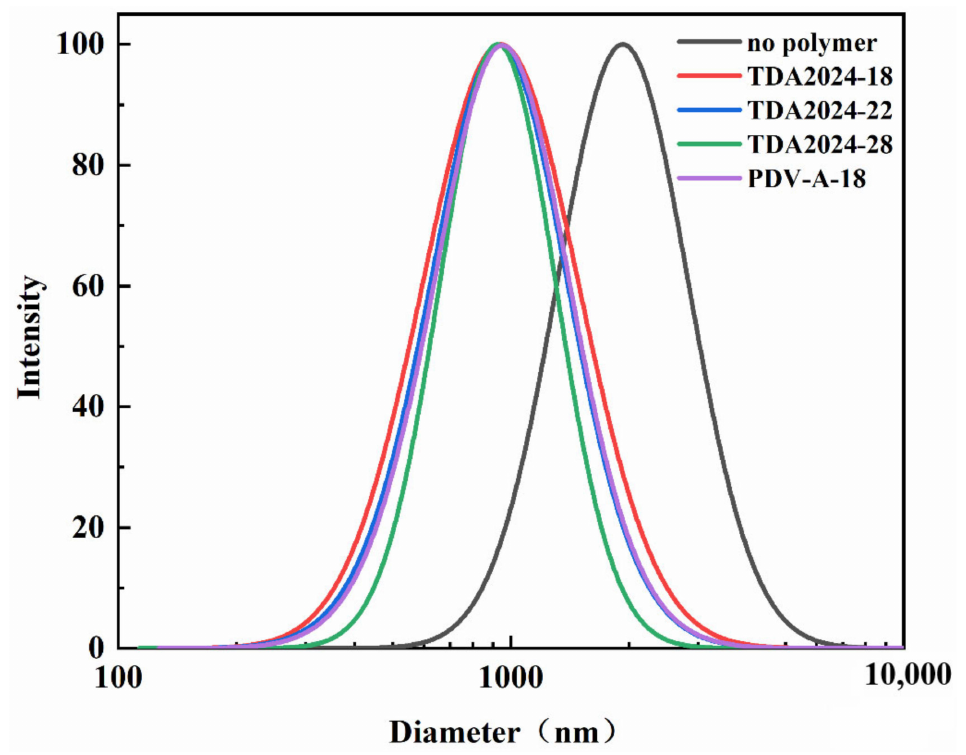
Figure 7. Diameter of asphaltene aggregates in model oil without and with bipolymers at 500